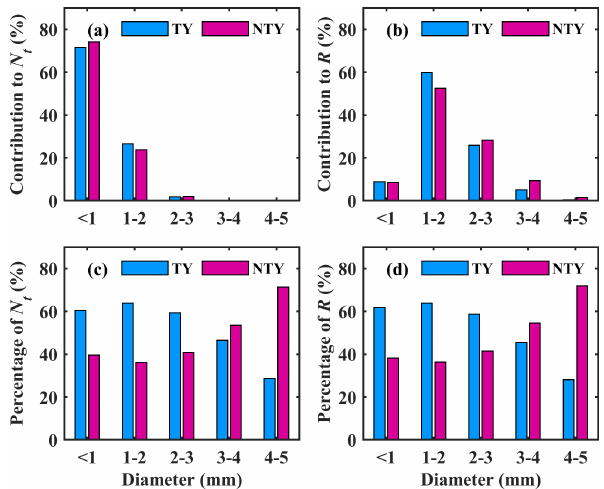
Figure 5. Contribution of drop diameter classes (diameter is < 1, 1–2, 2–3, 3–4, and 4–5mm) to (a) total number concentra- tion N t (m − 3 ) and (b) rainfall rate R (mmh − 1 ) in typhoon (TY) and non-typhoon (NTY) rainfall. The occurrence percentage of (c) total number concentration N t (m − 3 ) and (d) rainfall rate R (mmh − 1 ) in each diameter class for typhoon (TY) and non-typhoon (NTY)